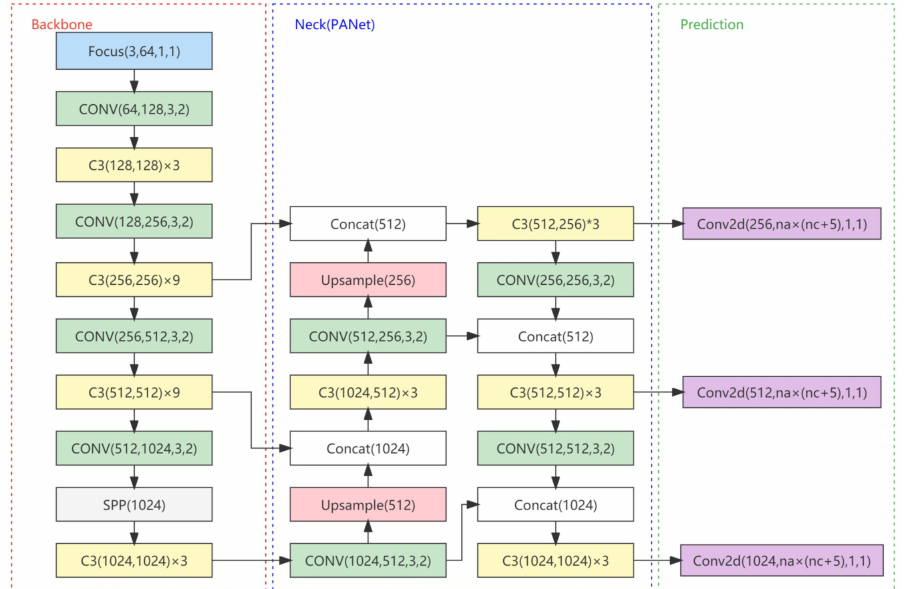
Figure 3. Network structure of